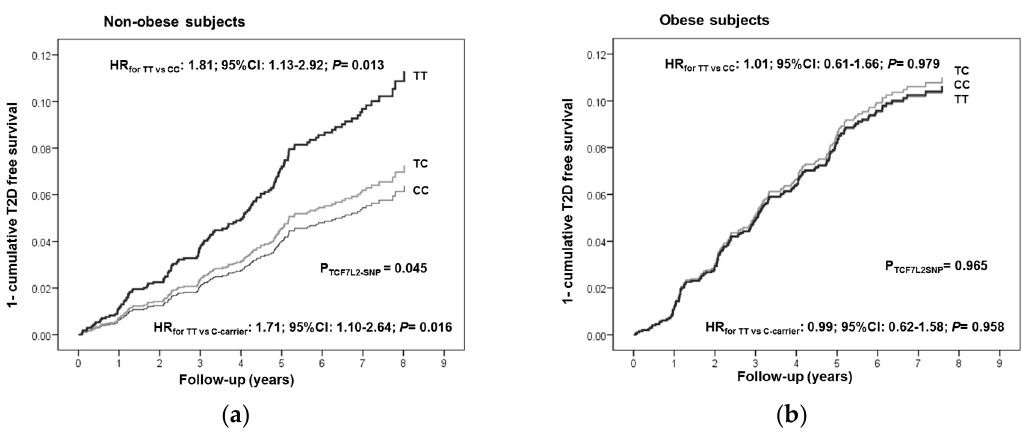
Figure 2. One minus the cumulative T2D-free survival by TCF7L2-rs7903146 genotypes in non-diabetic subjects at baseline ( n = 3607) depending of the obesity status: non-obese subjects ( a ) and obese subjects ( b ). Cox regression models with outcome of T2D incidence by the TCF7L2-rs7903146 polymorphism (CC, CT and TT) were adjusted for sex, age, center, intervention group, alcohol, smoking, total energy intake and adherence to the Mediterranean diet, physical activity, smoking, drinking, dyslipidemia, and hypertension at baseline. HR and 95% CI were obtained in the multivariable adjusted model. The p -values for the TCF7L2 polymorphism and for the corresponding genotypes (TT versus CC or TT versus C-carriers) were obtained in the multivariable adjusted models.